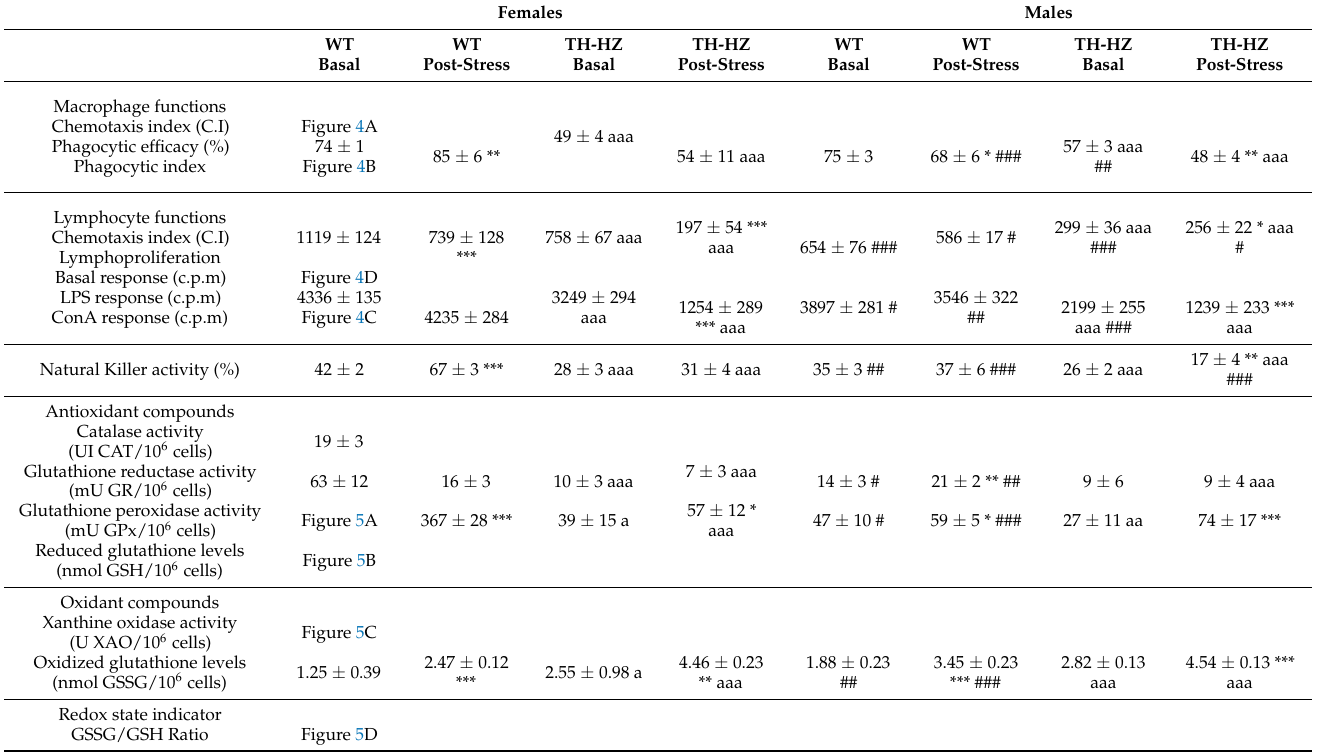
Each value represents the mean ± standard deviation of values corresponding to 6 animals. * p < 0.05, ** p < 0.01, *** p < 0.001 compared to basal condition, a p < 0.05, aa p < 0.01, aaa p < 0.001 compared to WT. # p < 0.05, ## p < 0.01, ### p < 0.001 compared to